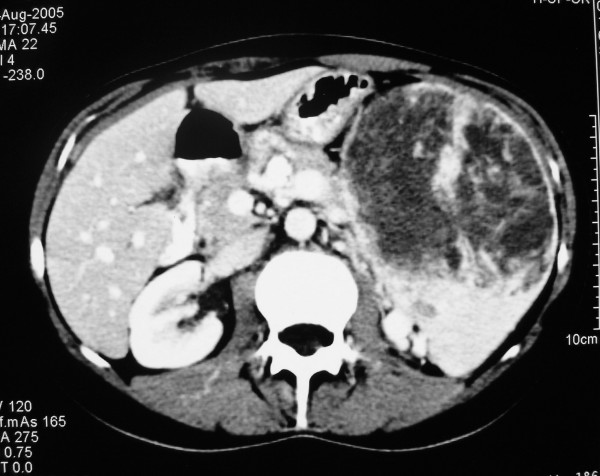
Computed tomography appearance of giant splenic hemangioma and liver hemangiomatosis. Cavernous hemangioma of the spleen and multiple hepatic cavernous hemangiomas displayed in a computed tomography hypodense image after IV contrast injection and peripheral, centripetal enhancement.